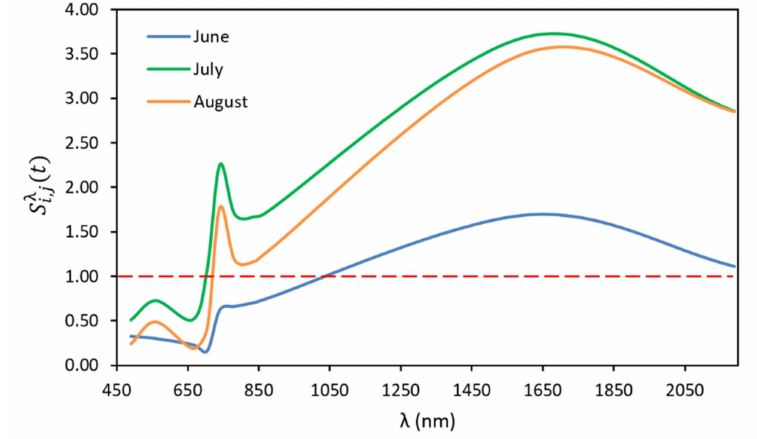
Figure 9. SMSIs separability analysis. Red line is the threshold over that observations are statistically different.